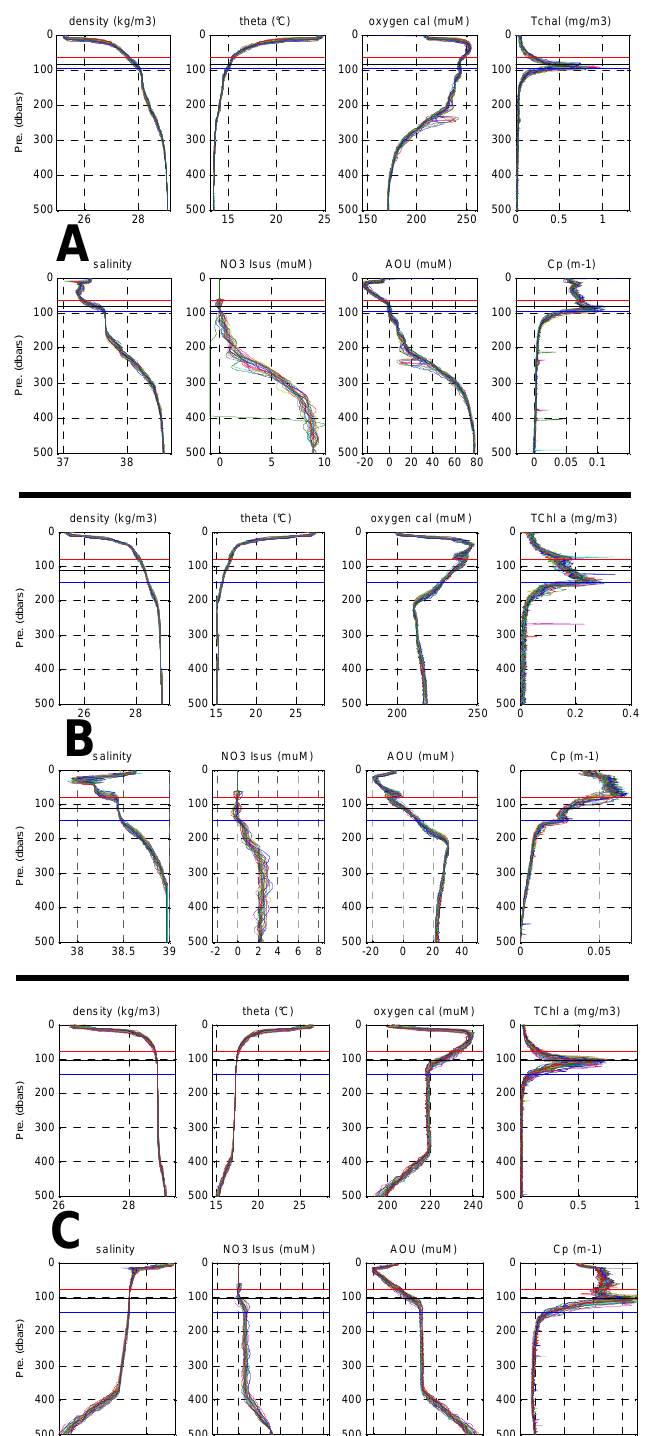
Fig. 10. Superposition of all vertical profiles vs. depth (0–500 dbars) obtained during occupation of the LD stations A, B, and C in uppermost position and from left to right: σ (kgm − 3 ) , θ ( ◦ C), O 2 (µmolkg − 1 ) , T chl a (mgm − 3 ) , and in lower position: S (PSU), ISUS nitrate concentration (µM), AOU (µmolkg − 1 ) and Cp (m − 1 ) . The best x-axis scale is chosen for each station. The 3, 1 and 0.3% of incident light level were reported on each graph using horizontal lines in red, green and blue,